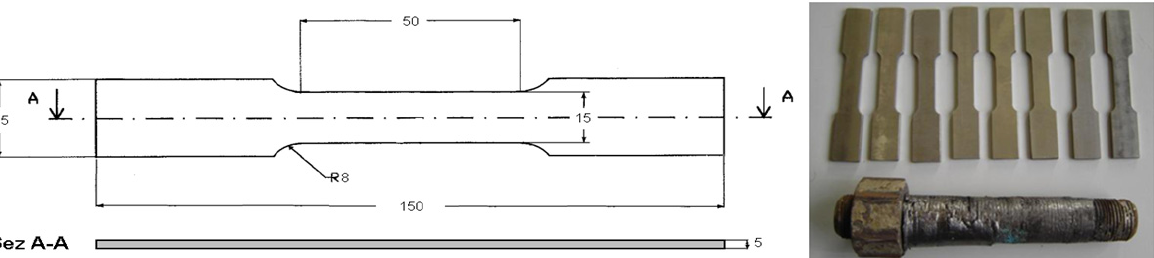
Figure 3: For each of the two tie rods slugs it has been created two clepsydra specimens (measures in